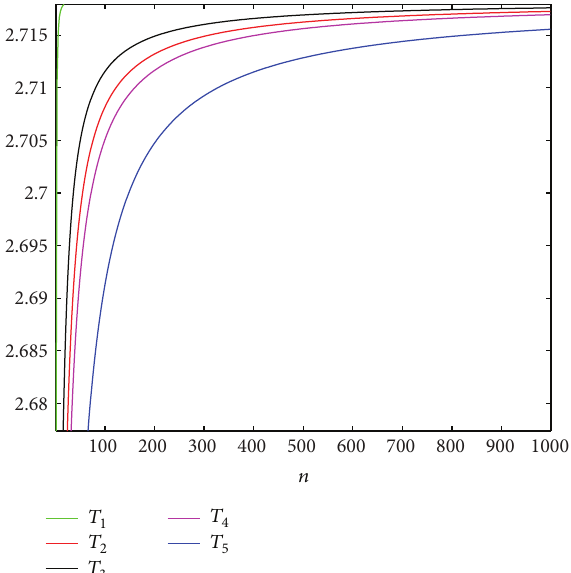
Figure 2: The variation trend of the different lower bounds value of the I. Schur